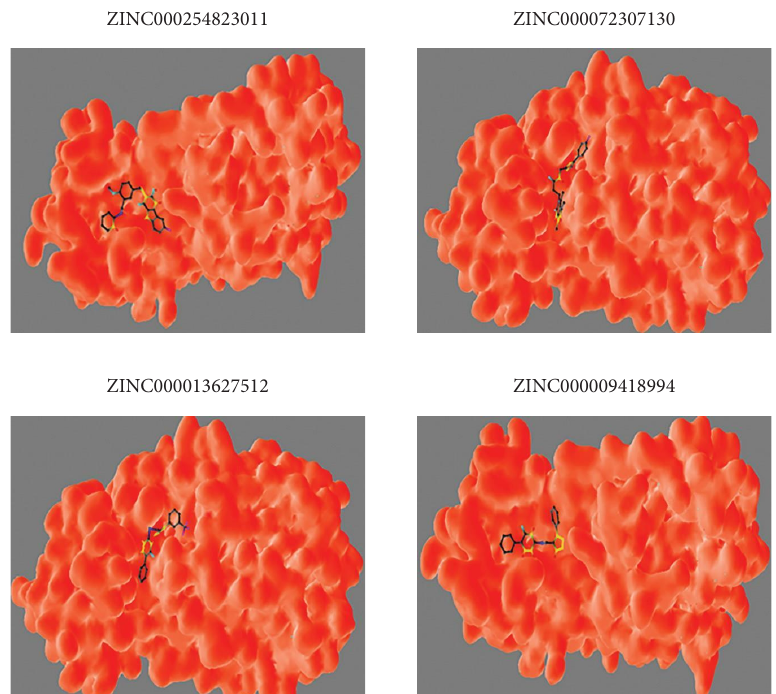
Figure 4: Image showing the 3D structures of the four final drug